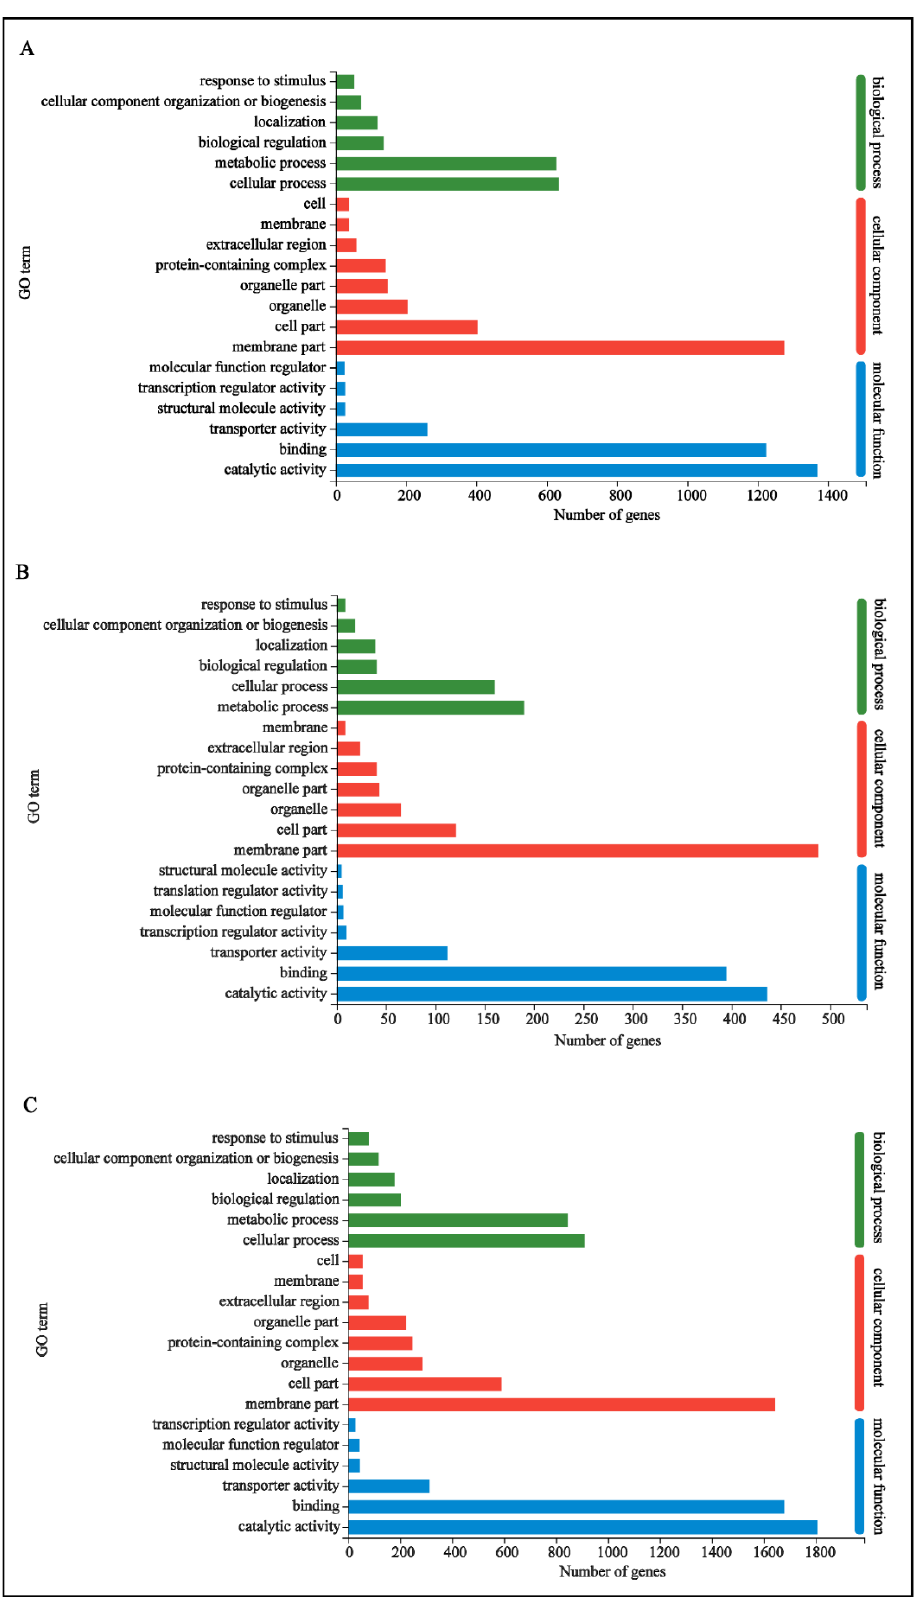
Figure 4. DEGs of control vs. metalaxyl group ( A ), control vs. bronopol group ( B ) and control vs. copper sulfate group ( C ) were assigned to GO categories, and the terms are categorized into three main GO categories. The top 20 enriched GO terms are presented in the figure.